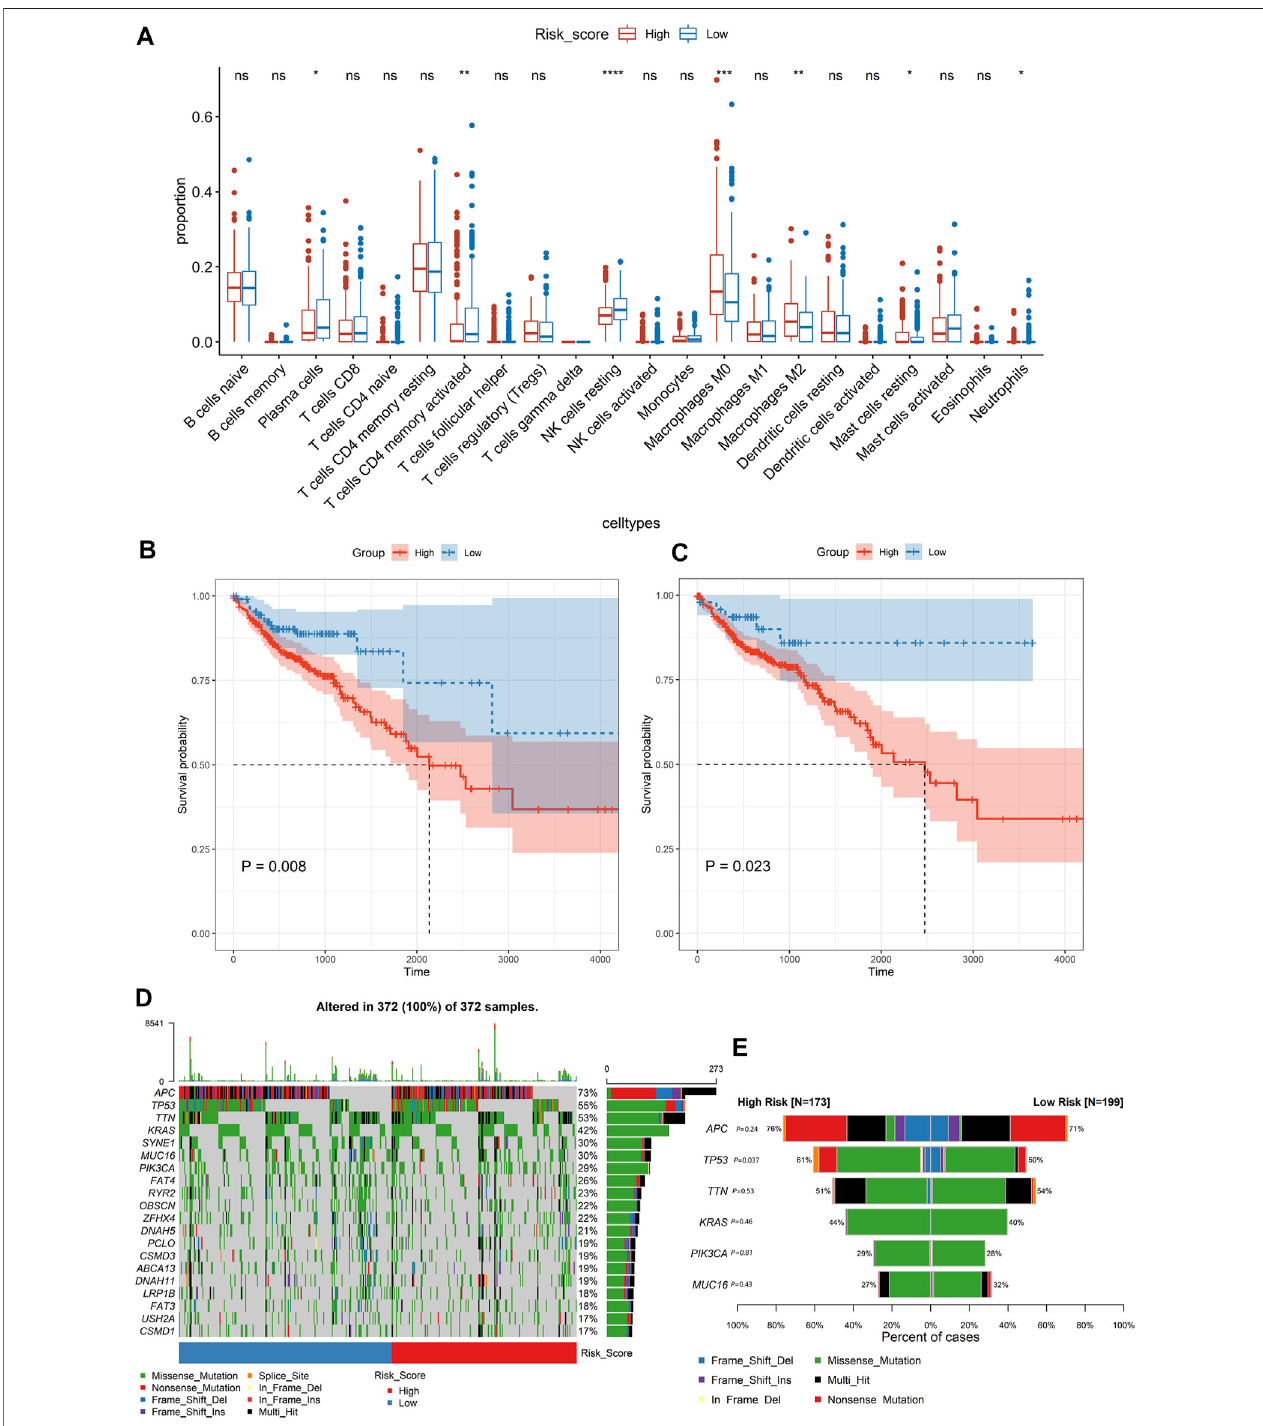
FIGURE 4 | Analysing the immune cell types and mutation pro fi les in high- and low-risk groups based on the whole dataset. (A) Comparing the difference of the proportions of immune cells between the low-risk group and high-risk group using the Wilcoxon test. The values of P were labeled above each boxplot with asterisks (* p < 0.05, ** p < 0.01, *** p < 0.001, **** p < 0.0001). (B, C) The Kaplan – Meier analysis ofthe relationship between the level ofresting NK cellsand M0 macrophages with patients ’ OS. (D) The mutation pro fi les ofcolon cancer patients in high- and low-risk groups. (E) Comparison of themutation ratebetweenthe high-risk group and low-risk